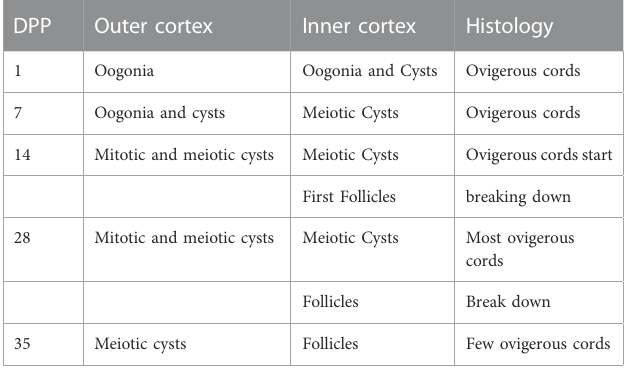
TABLE 2 Time scale of postnatal rabbit ovaries at which cysts and follicles are formed. The breakdown of rabbit cysts takes place in a stepwise fashion over 35 days. DPP: days